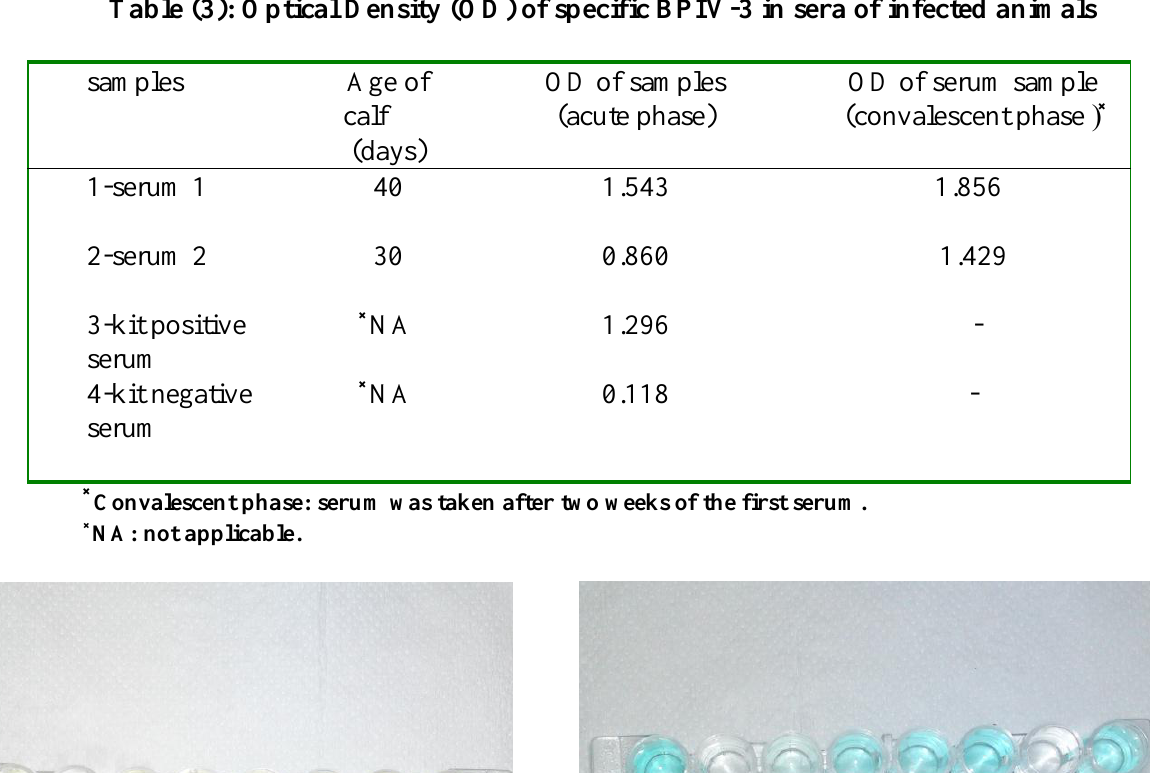
Table (3): Optical Density (OD) of specific BPIV-3 in sera of infected animals